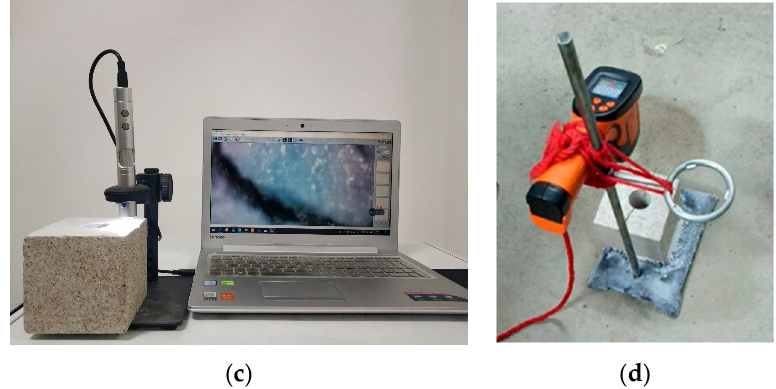
Figure 2. Instruments used in the experiment: ( a ) high temperature box furnace, ( b ) low temperature box, ( c ) digital microscope, and ( d ) infrared radiation thermometers.